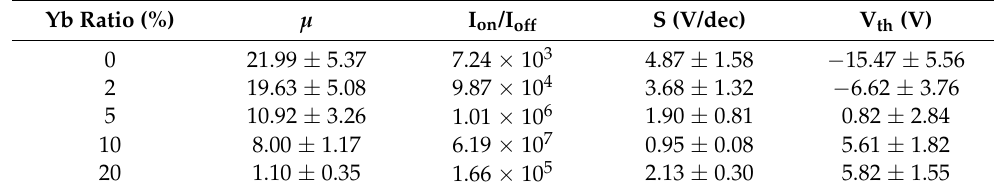
Figure 9. Histogram of: ( a ) mobility, ( b ) threshold voltage, and ( c ) subthreshold slope for the In-Yb-O TFTs with indicated Yb doping ratios. Table 2. Electrical performance parameters of In-Yb-O TFTs with different Yb